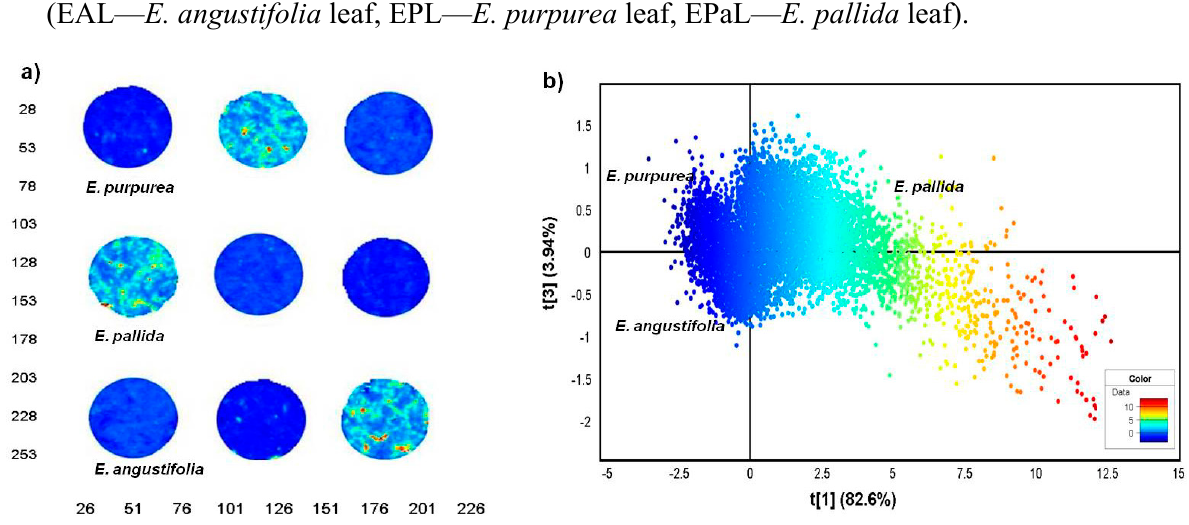
Figure 6. PCA score image (t1) of Echinacea leaf powders based on colour amplitudes ( a ). The corresponding score plot (PC1 vs. PC3) shows minimal separation of the pixel clusters ( b ).